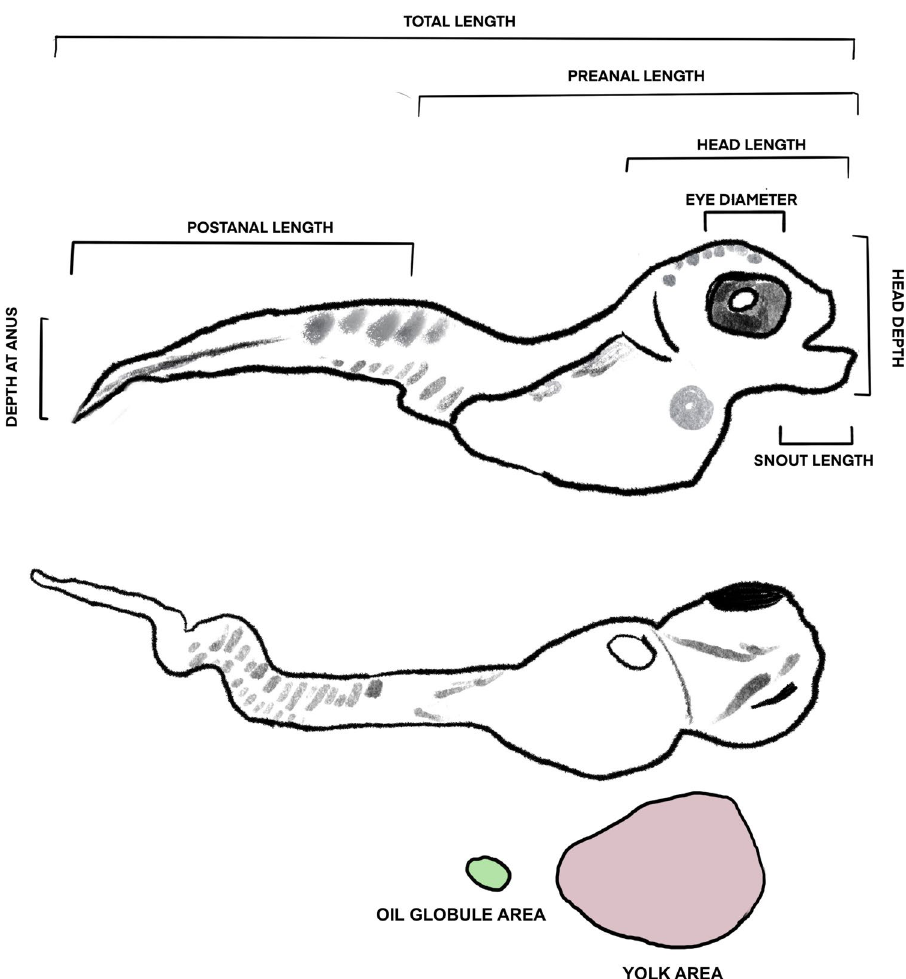
Figure 6. Illustration of the 10 measurements taken for each larval image using